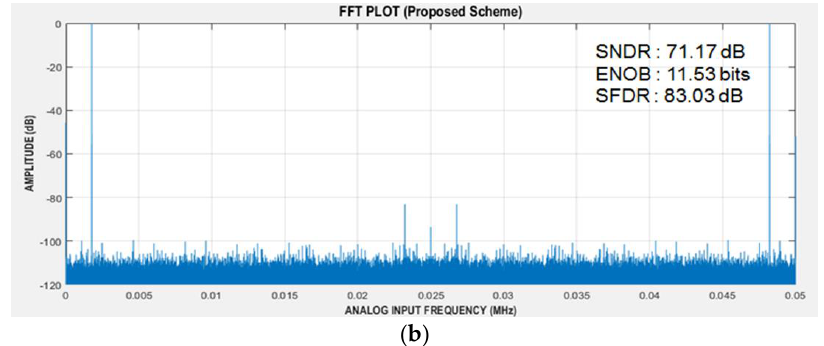
Figure 12. Measured 262144-point fast Fourier transform (FFT) spectrums at 1.777 kHz input ( a ) with ( b ) without alternate sampling and error correction scheme.